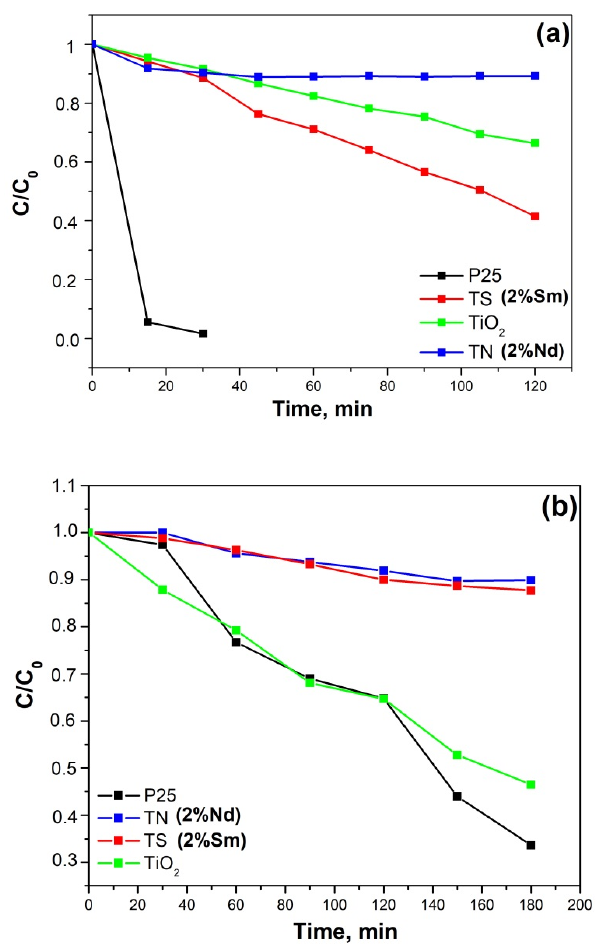
Figure 7. Photocatalytic activity against Malachite green of both samples TiO 2 /2%Nd and TiO 2 /2%Sm compared to pure TiO 2 obtained by metal alkoxide and Degussa P25: ( a ) under UV ir- radiation; ( b ) under Vis irradiation.